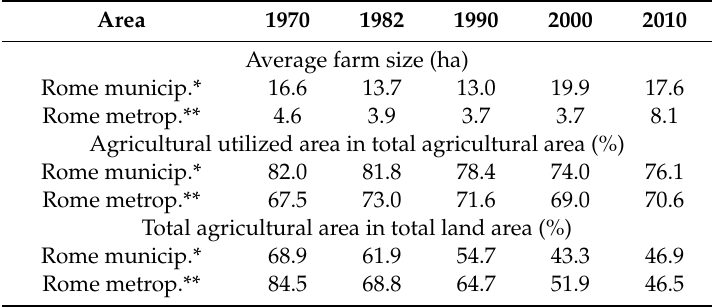
Table 2. Selected variables describing the agricultural system in the study area by years, 1970–2010.